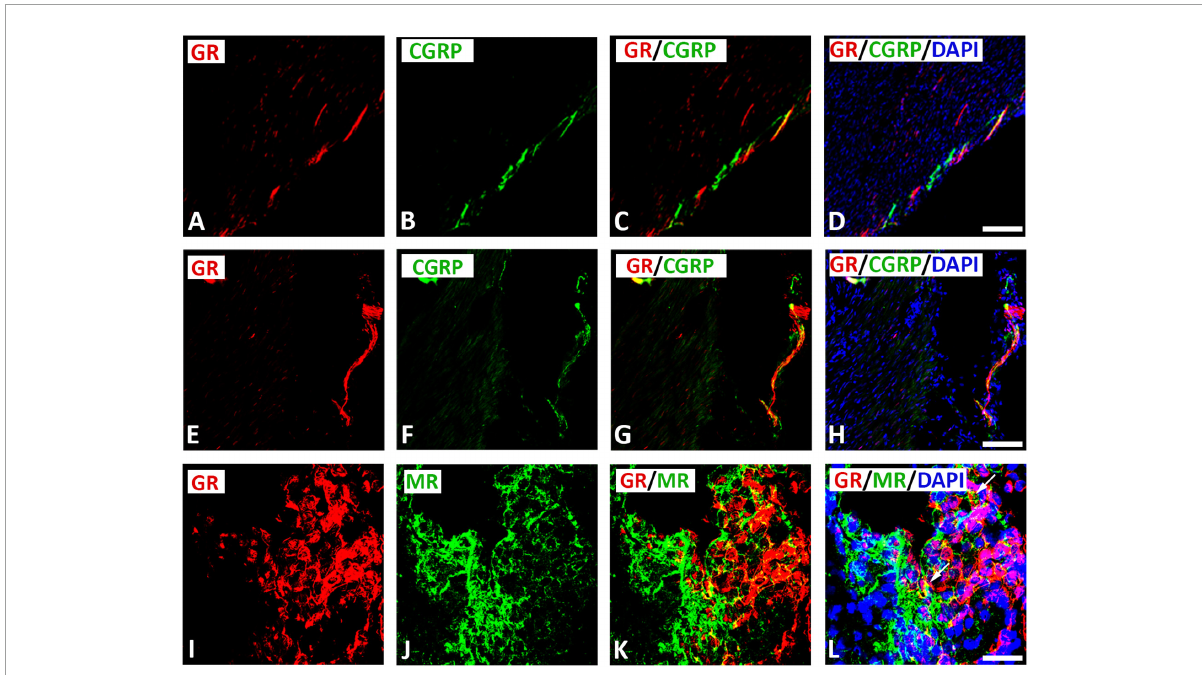
FIGURE6 Confocal microscopy of GR (A,E,I,M) with sensory neuronal marker CGRP (B,F) or MR (J,N) immunofluorescence ( red fluorescence) in intracardiac ganglia of tissue sections. (A–H) Show GR-IR nerve fibers rarely express CGRP within atrium tissue sections. (I–L) Is gelatine mounted tissue section of atria (10 µ m thickness) showing some populations of neuronal cells co-expressing GR with MR ( yellow fluorescence ) (arrow); however, other populations of neuronal cells expressed GR or MR alone. In addition, neuronal cells express only GR are in close contact with MR-immunoreactive cells. (A–H) = 40 µ m; (I–L) = 120 µ